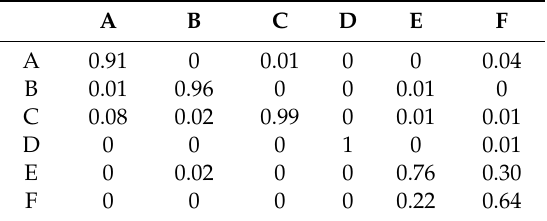
Table 2. Classification accuracy of the deep learning